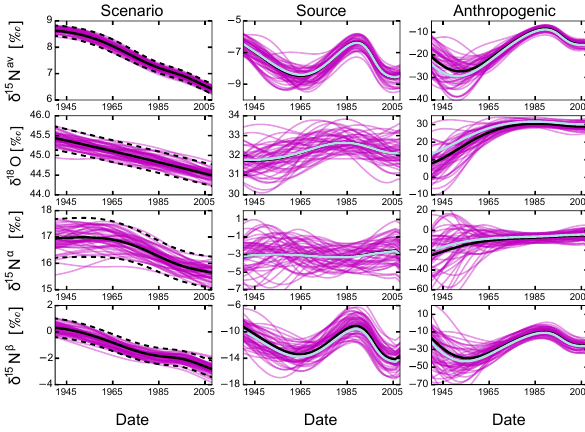
Figure D2. Left panels: historic evolution of δ 15 N av , δ 18 O, δ 15 N α , and δ 15 N β in N 2 O as derived from the firn air reconstruction. The solid black line represents the best-fit scenario, while the dashed ones represent the respective uncertainties as determined by the reconstruction method. Magenta lines represent the emissions that are required to produce the magenta N 2 O histories in the left pan- els. Middle and right panels: isotope signatures of the total emitted N 2 O and anthropogenic source, respectively, assuming a change in the lifetime from 123 years in 1700 to 119 years in 2008 (relative change similar to Prather et al., 2015) in light blue. The solid black line represents the result for the best-fit reconstruction, while ma- genta lines represent the results for the individual scenarios from the top panel (lifetime kept constant at 123 years) as used in the main